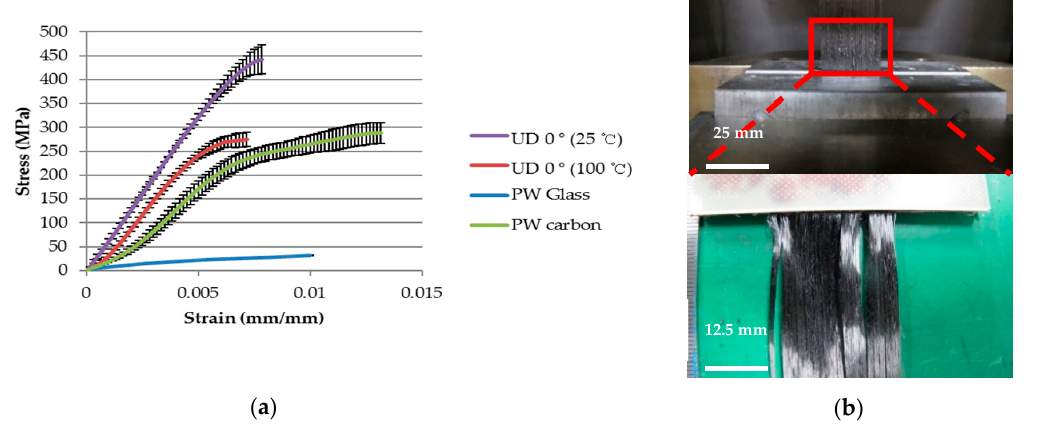
Figure 4. ( a ) Non-linear stress-strain curves for each prepreg at 100 °C; ( b ) Enlargement of UD 0° prepreg images after a high temperature tensile test. Table 4. Coefficient of friction between tool and prepreg with three repeated friction force measurements at the thermoforming conditions.